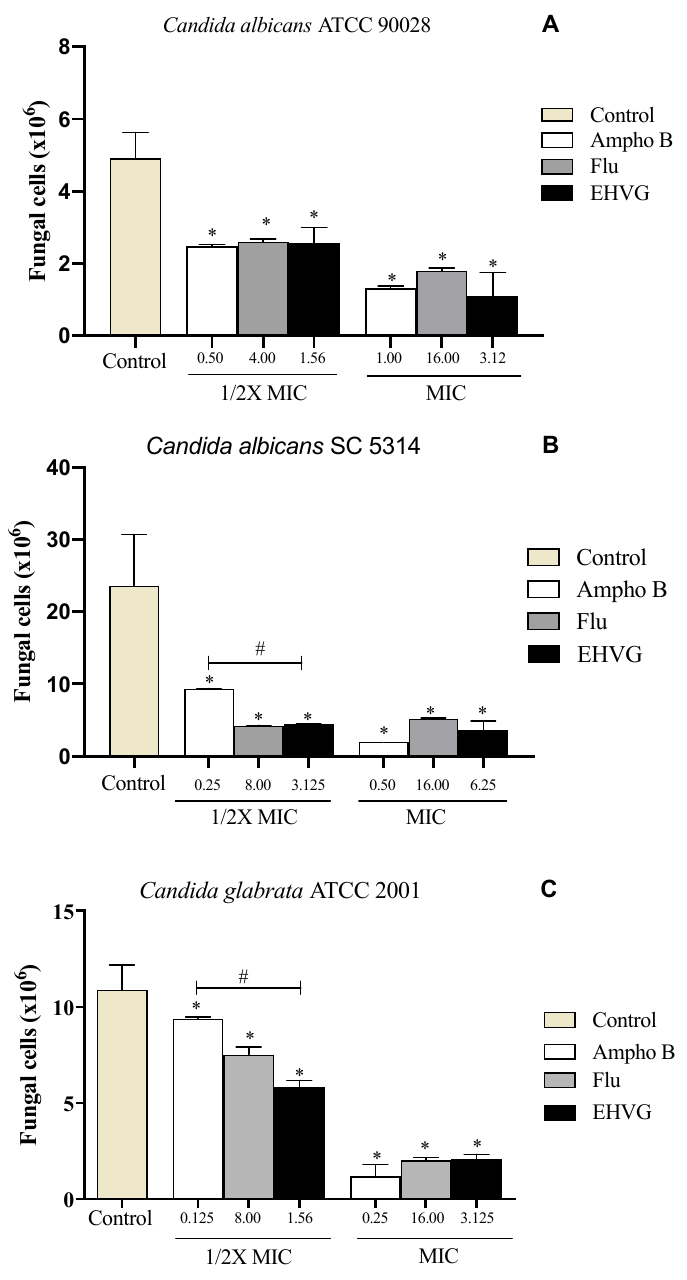
Figure 7. EHVG inhibited the adhesion of Candida albicans ATCC 90,028 ( A ), C. albicans SC5314 ( B ), and C. glabrata ATCC 2001 ( C ) in cultures treated with concentrations of 1 / 2 MIC and MIC when compared to untreated samples (control). The EHVG-treated cultures were also compared to those treated with the reference drugs Amphotericin B (Ampho B) or Fluconazole (Flu). (*) p < 0.05 differs from untreated control; (#) p < 0.05 differs from Amphotericin B.